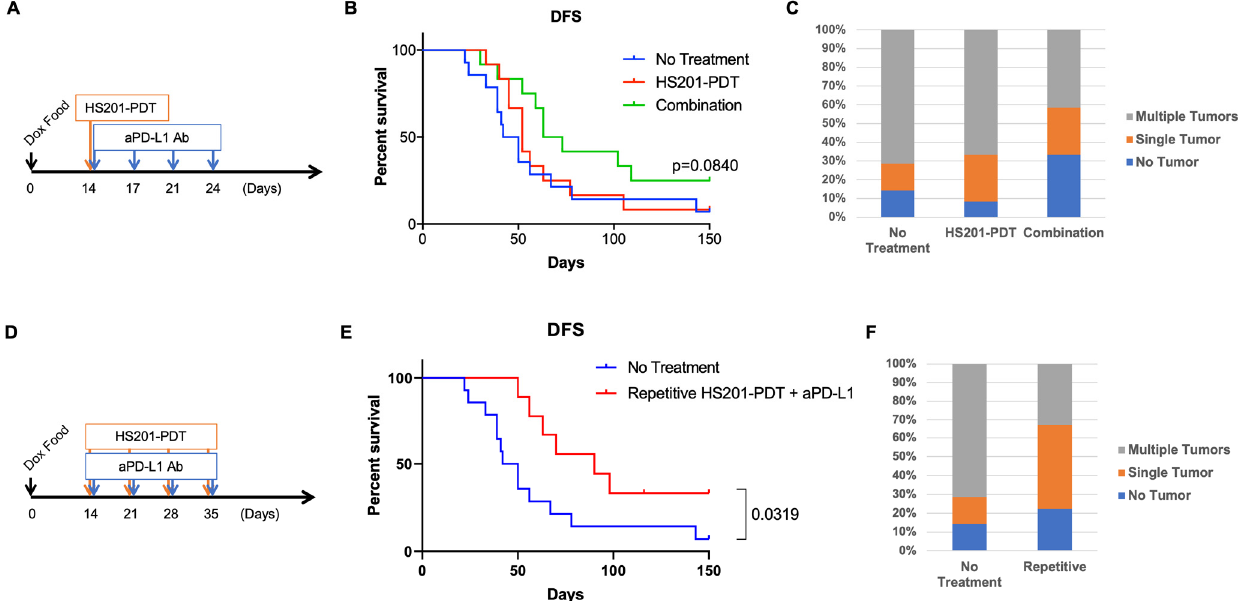
Figure 5. Combination strategies of preventive HS201-PDT and anti-PD-L1 antibody. ( A ) Schedule of anti-PD-L1 administration combined with a single HS201-PDT treatment. Mice were given doxycycline diet starting on day 0, and HS201-PDT was given on day 14. Starting on the same day, anti-PD-L1 antibody (250 µ g/injection) was intraperitoneally administered to mice twice a week for 2 weeks. N = 14 mice for no-treatment group, n = 12 for both HS201-PDT monotherapy group and the combination therapy group. ( B ) Disease-free survivals of HER2d16 Tg mice are shown. X axis shows the days after the initiation of doxycycline diet. Mice were monitored until day 150 after